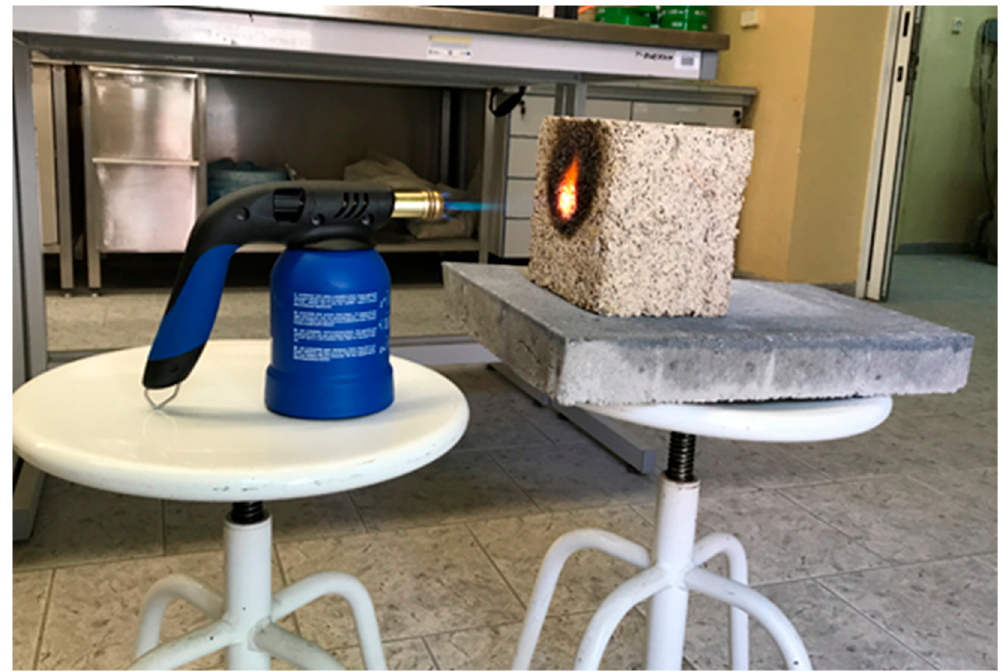
Figure 4. Hemp lime composite flame test, with the tested sample placed at a distance of 10 cm away from the flame source.